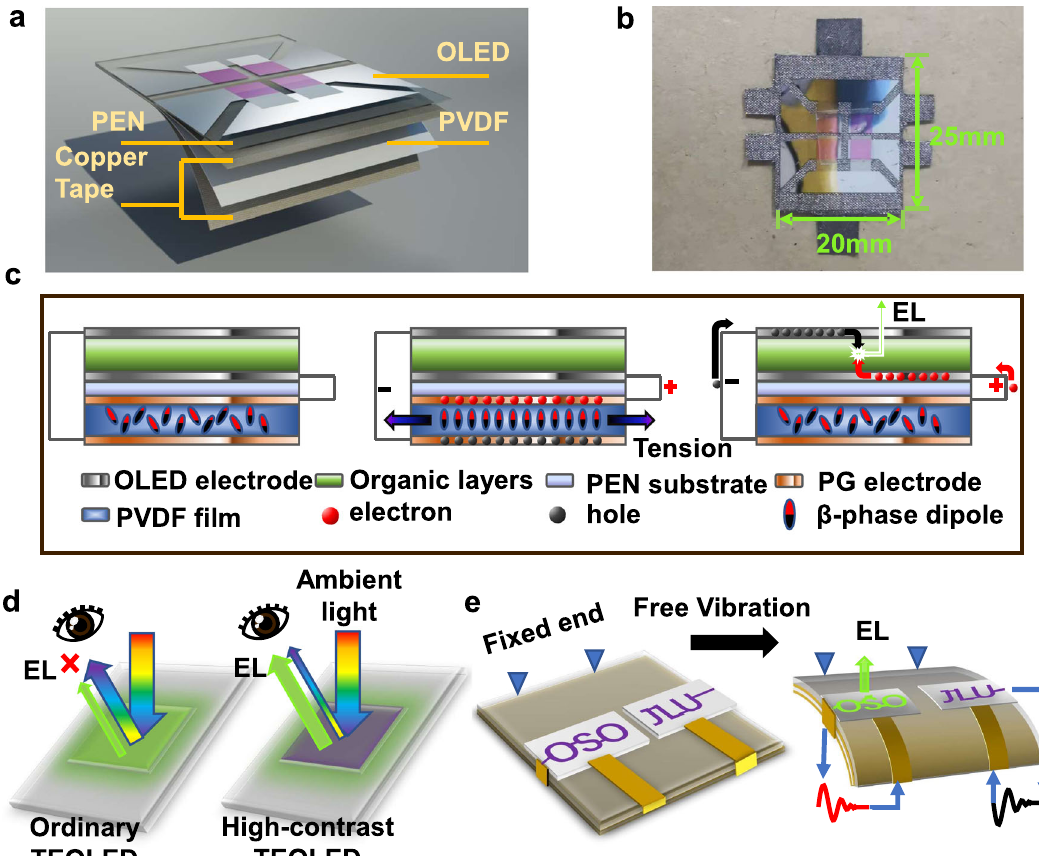
d Schematic diagram of the EL (green arrows) visibility of ordinary and high- contrast TEOLEDs to human eyes under ambient light noise (rainbow arrows). e Schematic diagram of the generation process of patterned light-pulse anti- counterfeitingsignal.Patternsinpurplerefertooffstatewhilegreenpatternrefers to EL generation. Red and black waveform indicate two directions of the power